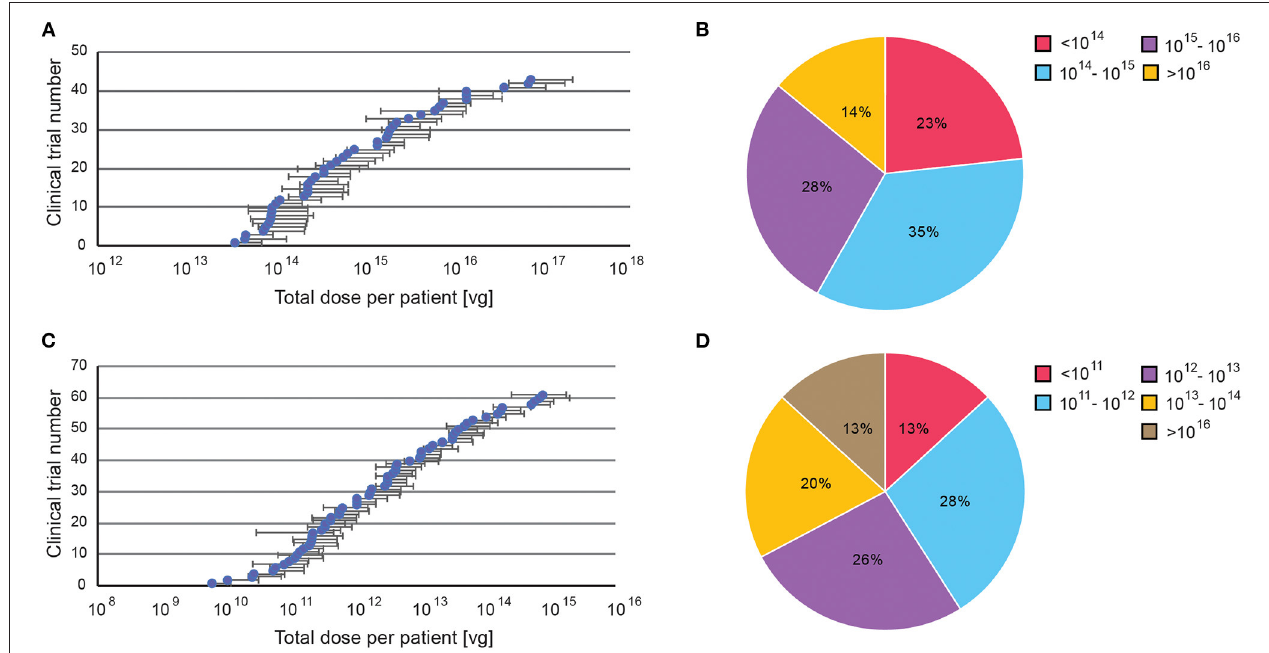
FIGURE 6 | A summary of dosage regime of AAV administered in clinical trials. Dosages were reported in viral genomes (vg) administrated per patient per dose, via either systemic or targeted administration. (A) Range of doses in systemic administration, (B) Percentage of clinical trials with specific AAV dose windows for systemic administration. (C) Range of doses in targeted administration (if disclosed). (D) Percentage of clinical trials with specific AAV dose windows for targeted administration. All data presented as a total injected dose per patient. For trials with dosages given in vg/kg body weight, the dose was calculated for an average body weight of adult person